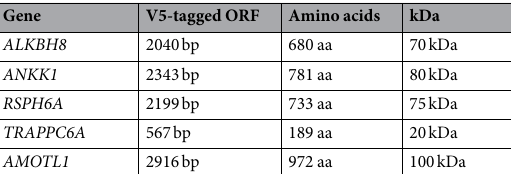
Gene V5-tagged ORF Amino acids